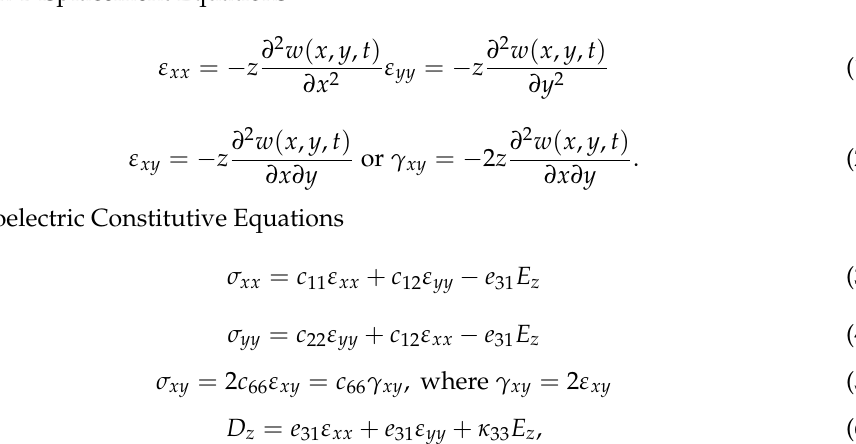
Figure 1. Elastic piezoelectric thick film on the Winkler − Fuss foundation. Strain-Displacement